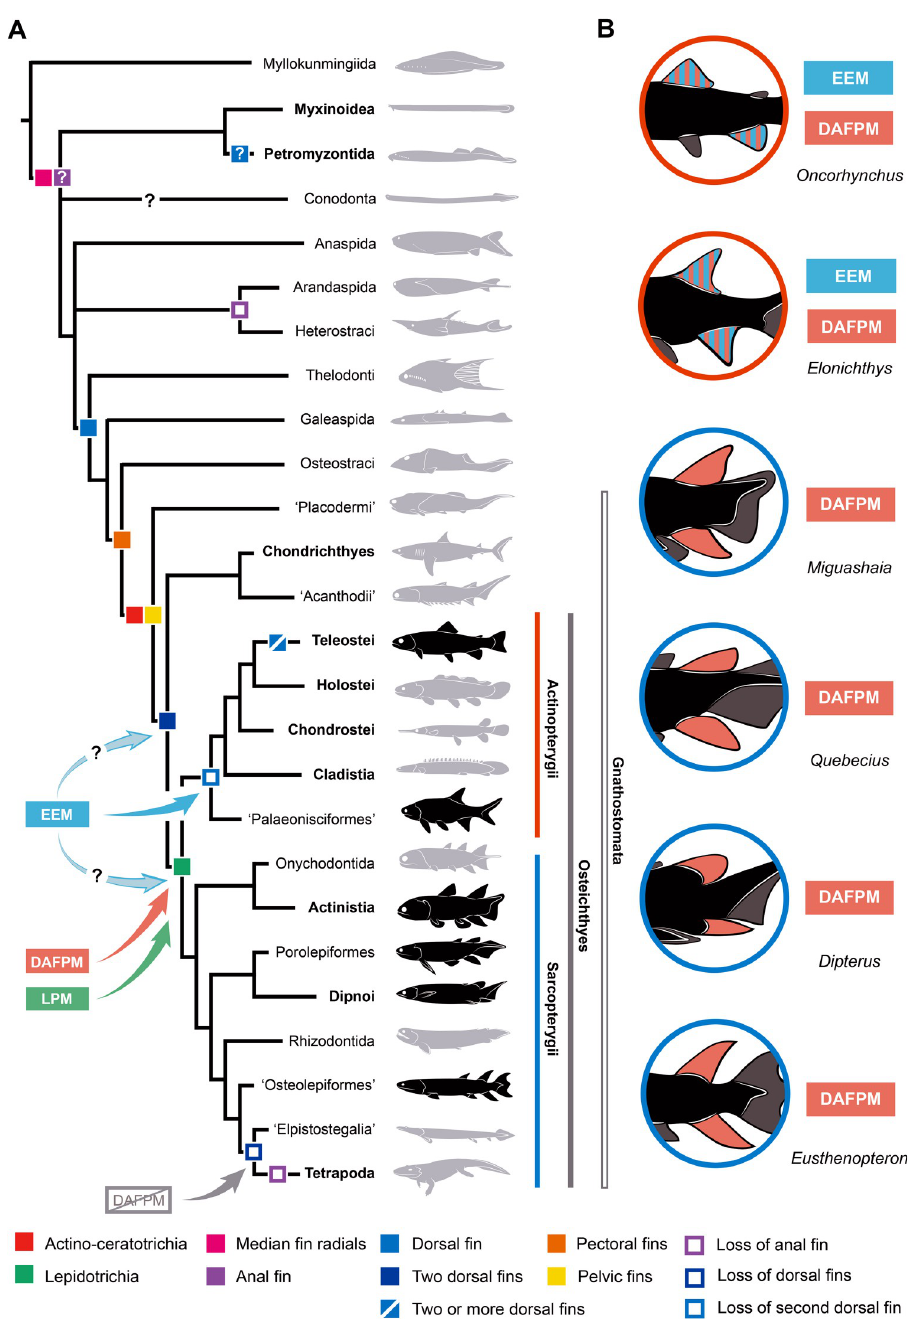
Fig 12. Vertebrate phylogeny illustrating the evolution of fin related characters and median fin modules. A, Interrelationships of the main groups of vertebrates and distribution of fin characters. Taxa in bold have living representatives. Fins have been plotted in the tree according to their definition as membranous outgrowths of the body walls internally supported by endoskeletal (e.g., radial bones) or exoskeletal (e.g., fin rays) elements and based on consensual hypotheses of homology (see main text for a discussion on the distribution of fins in the selected taxa). Question marks represent uncertainties. Preferred tree topology combined from [81–83] for non-gnathostomes, [84, 85] for actinopterygians, and [15, 86] for sarcopterygians; B, Distribution of median fin modules (DAFPM and EEM) in the studied species. DAFPM, dorsal and anal fin patterning module; EEM, endoskeleton exoskeleton module; LPM, lepidotrichia patterning